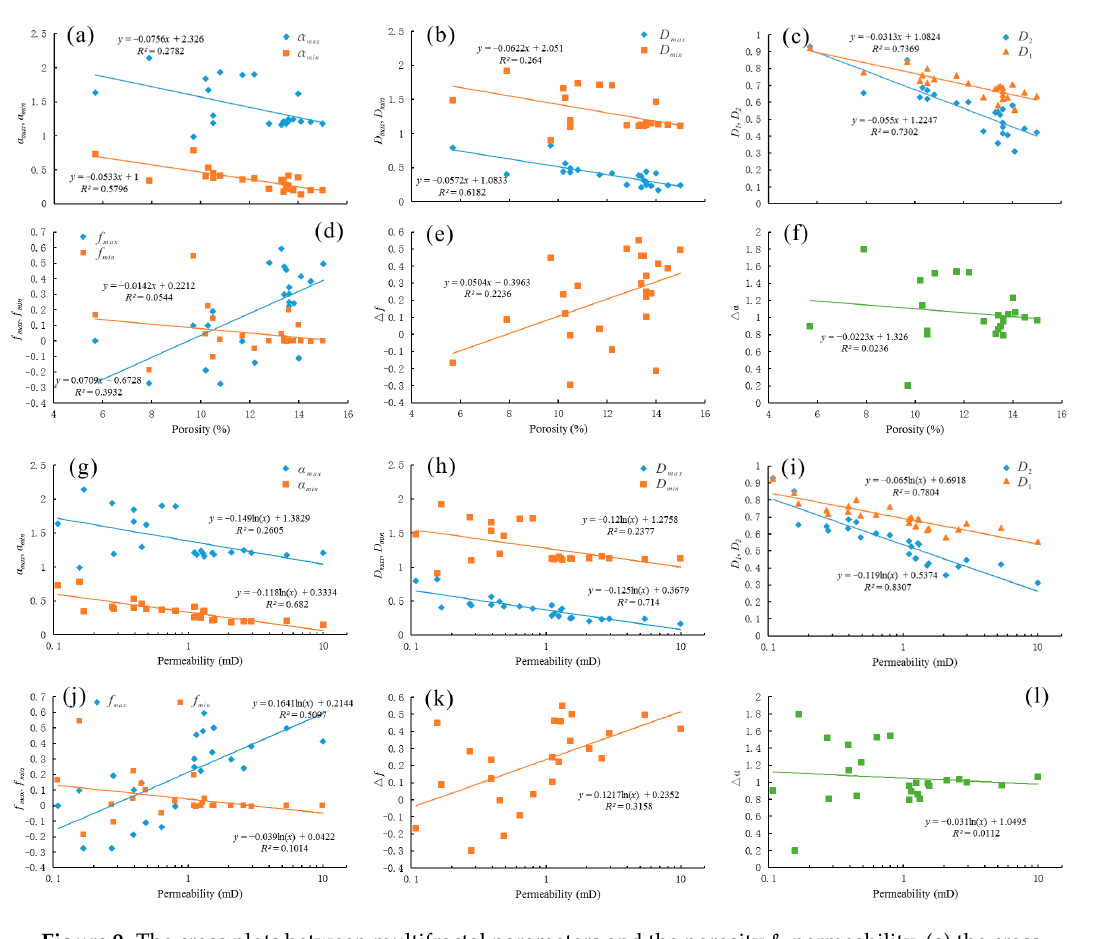
Figure 9. The cross plots between multifractal parameters and the porosity & permeability. ( a ) the cross plots between α max , α min and porosity; ( b ) the cross plots between D max , D min and porosity; ( c ) the cross plots between D 1 , D 2 and porosity; ( d ) the cross plots between f max , f min and porosity; ( e ) the cross plot between (cid:52) f and porosity; ( f ) the cross plot between ∆ α and porosity; ( g ) the cross plots between α max , α min and permeability; ( h ) the cross plots between D max , D min and permeability; ( i ) the cross plots between D 1 , D 2 and permeability; ( j ) the cross plots between f max , f min and permeability; ( k ) the cross plot between (cid:52) f and permeability; ( l ) the cross plot between ∆ α and permeability. They can be used to effectively indicate the heterogeneity of pore structure. Meanwhile, the other multifractal parameters, α max , D min , (cid:1858) max , (cid:1858) min , Δ α and △(cid:1858) display weak correlations with porosity and permeability, with correlation coefficients ranging from 0.0112 to 0.5097. Although these parameters are different in different types of reservoirs, the correlation coefficients are still not high enough, which might relate to the pore throat tortuosity and different cementation type. In conclusion, multifractal parameters, α min , D max , D 1 , and D 2 are great indicators of the porosity and permeability in tight sandstone reservoirs. 3.7. The Relationship between Multifractal Parameters and Pore Structure Parameters The cross plots between multifractal parameters and MICP parameters are shown in Figure 10, and the correlation coefficients are listed in Table 5. There are fine correlations between the pore structure parameters and multifractal parameters, too. P 50 and P d are positively correlated with α max , α min , D max , D min , D 1 , D 2 , (cid:1858) min and Δ α , but negatively correlated with (cid:1858) max and △(cid:1858) , with logarithmic curve fitting. (cid:1870)̅ is negatively correlated with α max , α min , D max , D min , D 1 , D 2 , (cid:1858) min and Δ α , but positively correlated with (cid:1858) max and △(cid:1858) , with logarithmic curve fitting. The correlation coefficients between small pore proportion and large proportion to multifractal parameters are good but totally opposite, as their contributions to the permeability are different. Combined with the preceding conclusions, the average pore radius (cid:1870)̅ and the displacement pressure P d are good parameters to reflect the heterogeneity of tight sandstone in the study area; the multifractal parameters α min , D max , D 1 and D 2